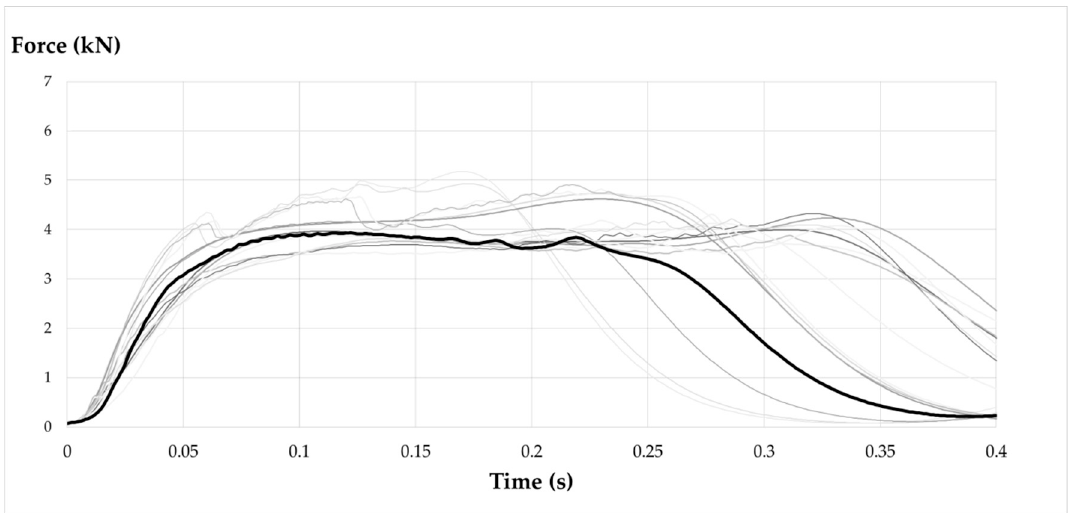
Figure 11. EAL time–force curve.